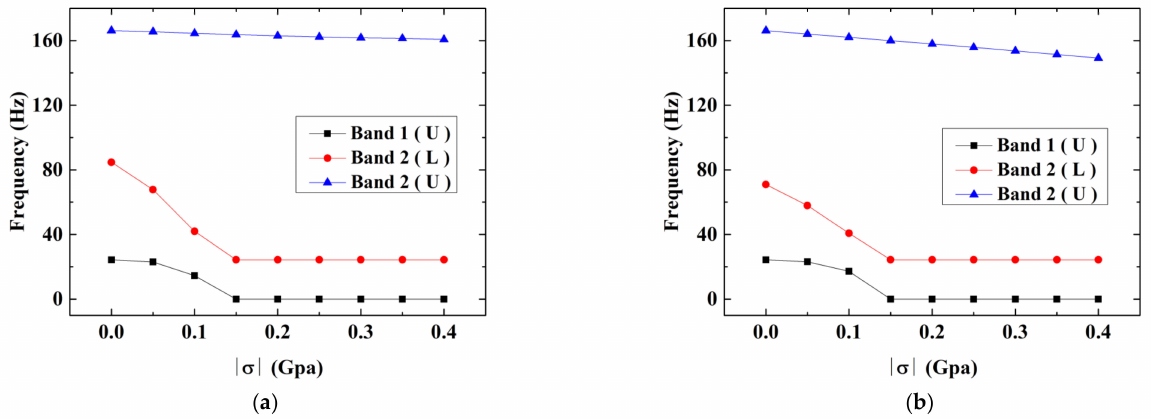
Figure 7. The influence of axial compressive stress on band gap: ( a ) Euler beam; ( b ) Timoshenko beam.